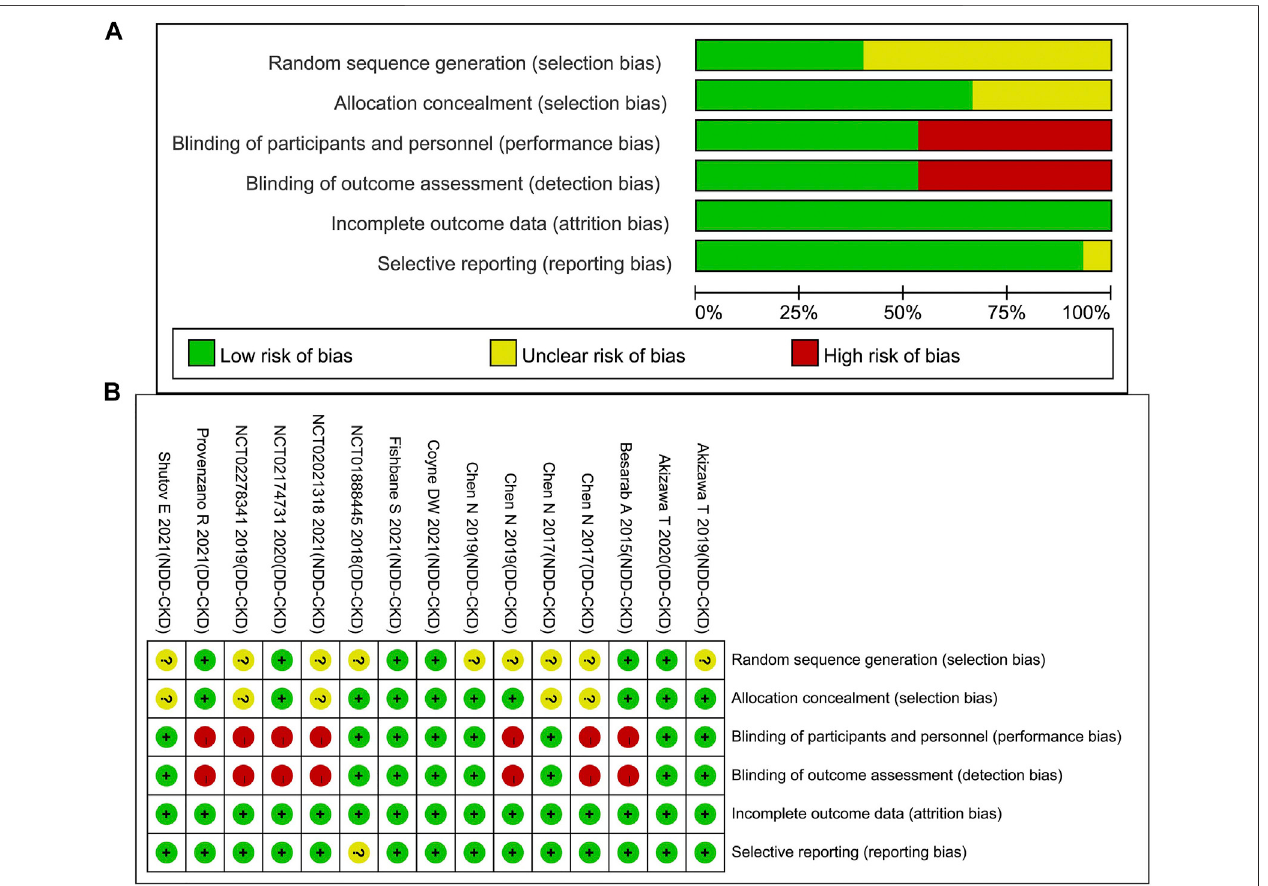
FIGURE 2 | Risk of bias graph (A) and summary (B)